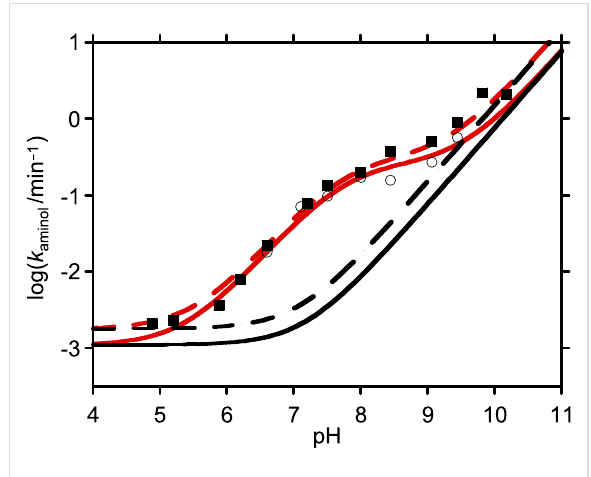
Figure 2: log k aminol vs pH for the combined aminolysis and hydrolysis of p -nitrophenyl ester 7 (R = p NP) and m -nitrophenyl ester 7 (R = m NP) in the presence of 0.05 M D-glucosamine at 25 °C. Squares correspond to data for p -nitrophenyl ester 7 (R = p NP); circles corres- pond to data for m -nitrophenyl ester 7 (R = m NP). The dashed black line corresponds to data fitting for the hydrolysis of p -nitrophenyl ester 7 (R = p NP) and the solid black line corresponds to data fitting for the hydrolysis of m -nitrophenyl ester 7 (R = m NP) (Figure 1). The dashed red line corresponds to data fitting for the combined aminolysis and hy- drolysis of p -nitrophenyl ester 7 (R = p NP); solid red line corresponds to data fitting for the combined aminolysis and hydrolysis of m -nitro- phenyl ester 7 (R = m